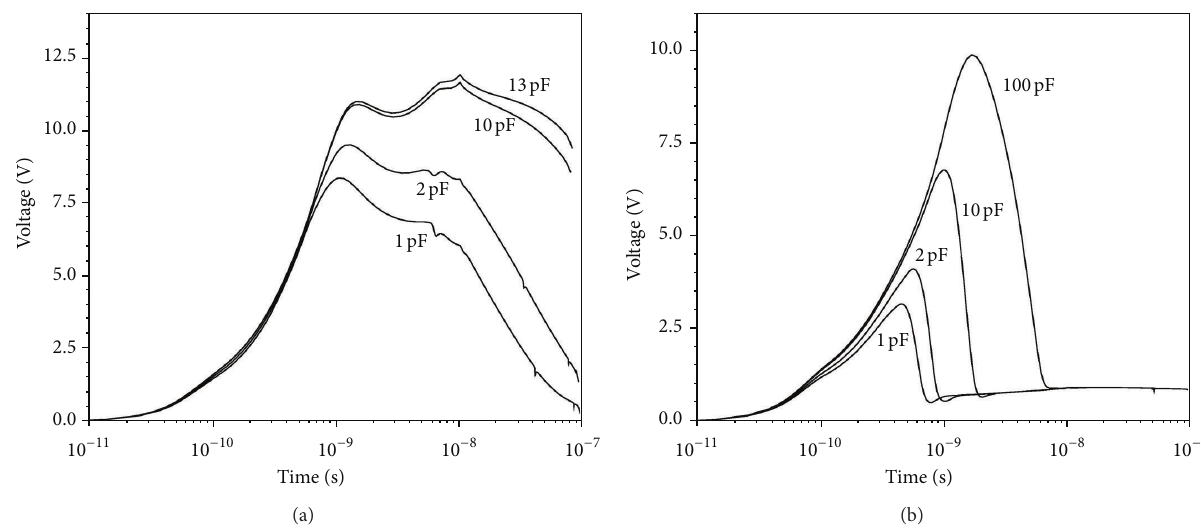
Figure 6: (a) The simulated gate voltage transient response with different gate capacitance parameters for the RC gate-coupling case. (b) The simulated gate voltage transient response with different gate capacitance parameters for the RC-SGT